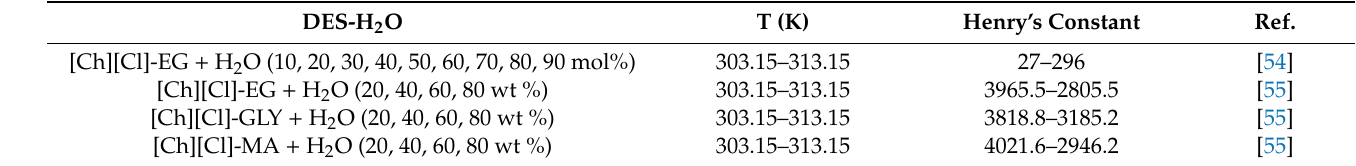
Table 5. Henry’s constant of DES–H 2 O hybrid